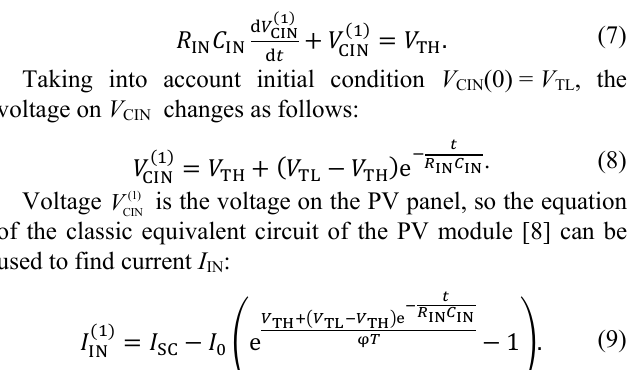
Fig. 6. Optimizer equivalent circuits at different transient intervals for analytical calculations: (a) generalized circuit; (b) transistor Q is closed; (c) transistor Q is